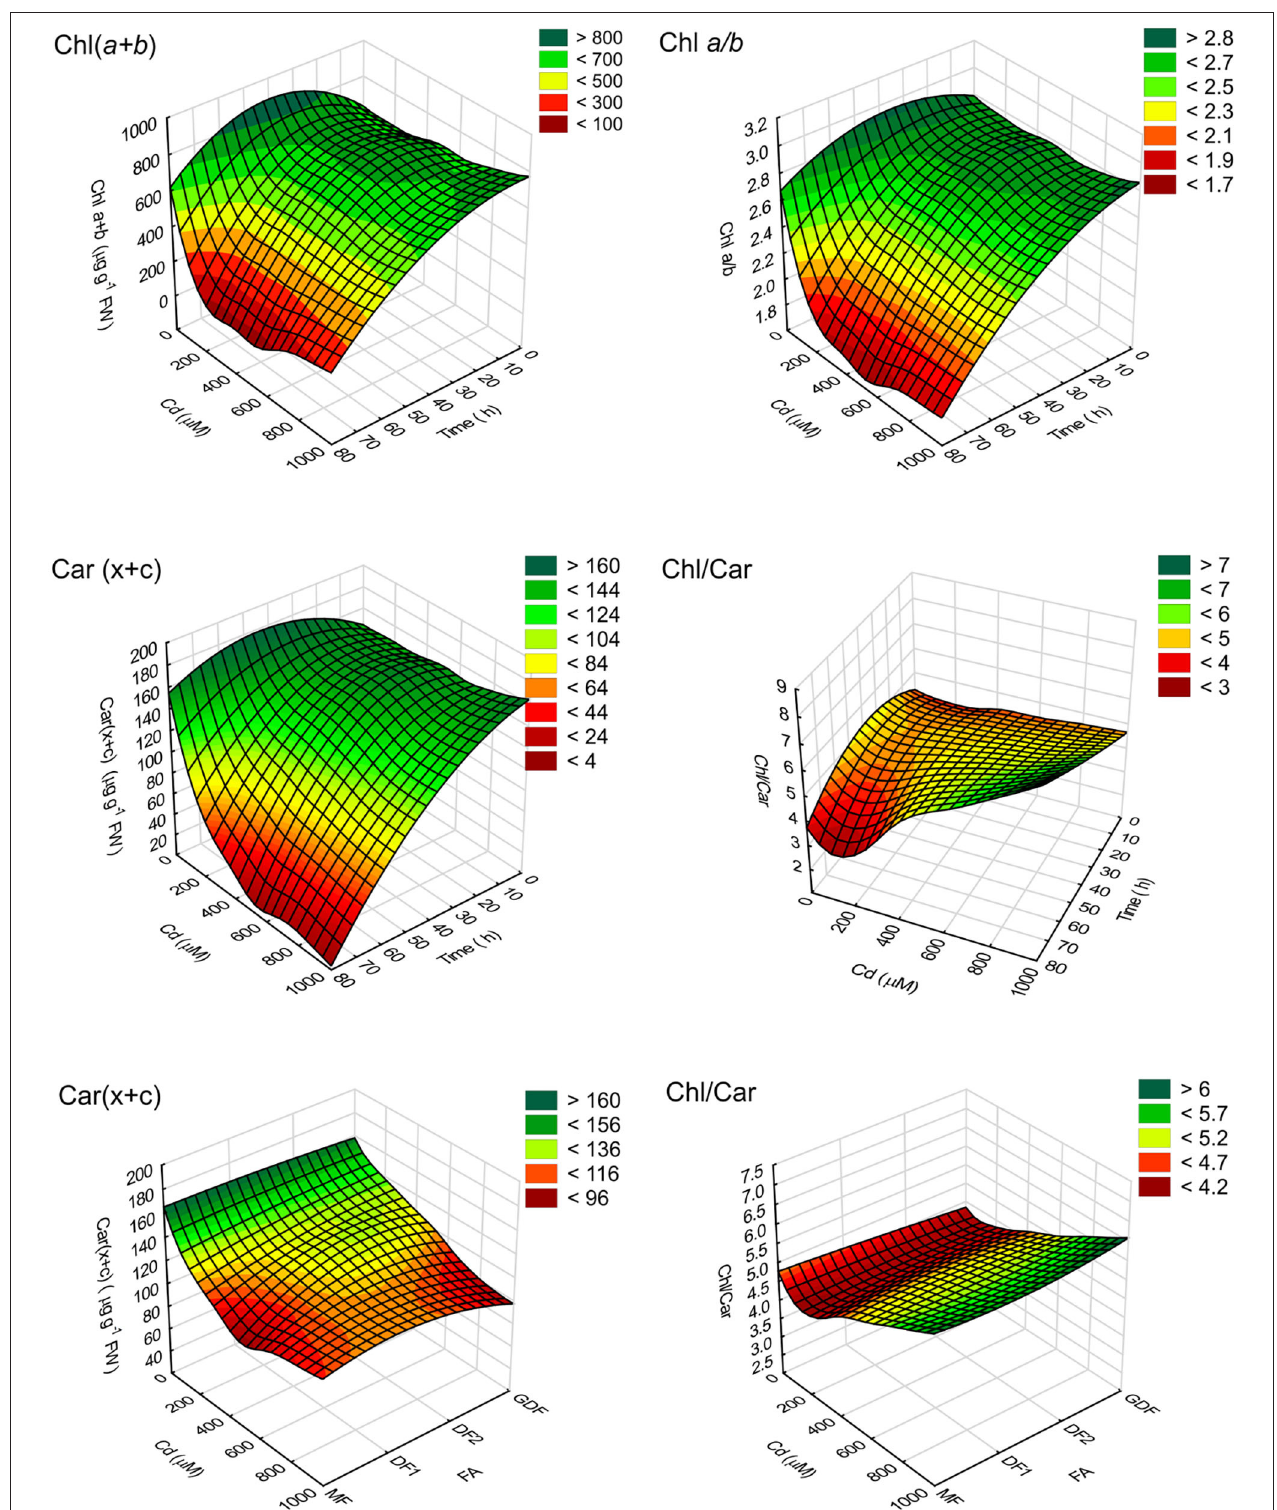
FIGURE 1 | 3D response surface plot (distance weighted least squares) of pigment content ( µ g g − 1 FW) and their ratios. Plots represent the relationship between time of exposure to different cadmium (Cd) concentrations (C0–C8) reconstructed using an MLP algorithm (4.MLP 6-4-4) of measured chlorophyll concentrations Chl( a + b ), total carotenoids, Car( x + c ), and pigment ratio (Chl a/b and Chl/Car).